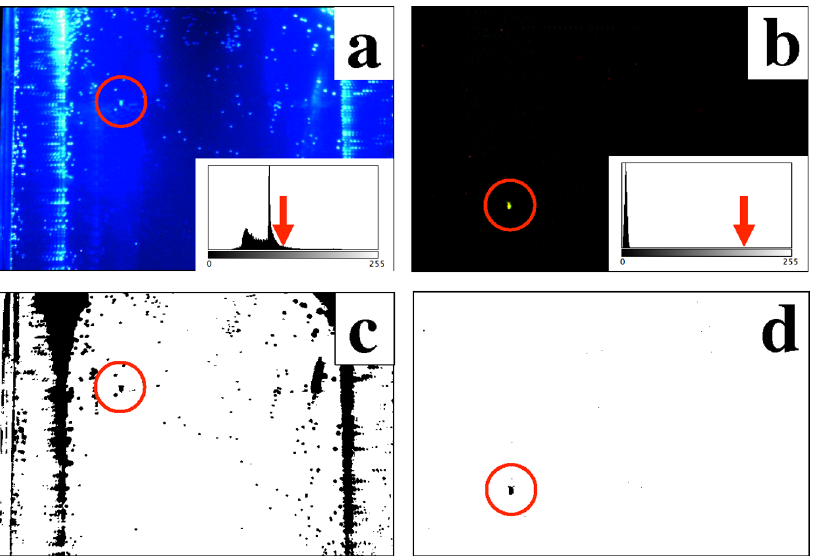
Figure 2. Comparison of image quality using traditional (unlabelled) and Q-dot labelled organisms ( D.magna ). Video frame crop of 600 6 400 pixel representing a cross-section of the aquarium for (a) unlabelled and (b) quantum dot labelled (585 nm) Daphnia , and respective binary images obtained by a fixed threshold value (c and d, respectively). Inlets are the frame luminosity histogram and red arrows indicate the Daphnia mean luminosity value. Daphnia position is indicated by red circles.